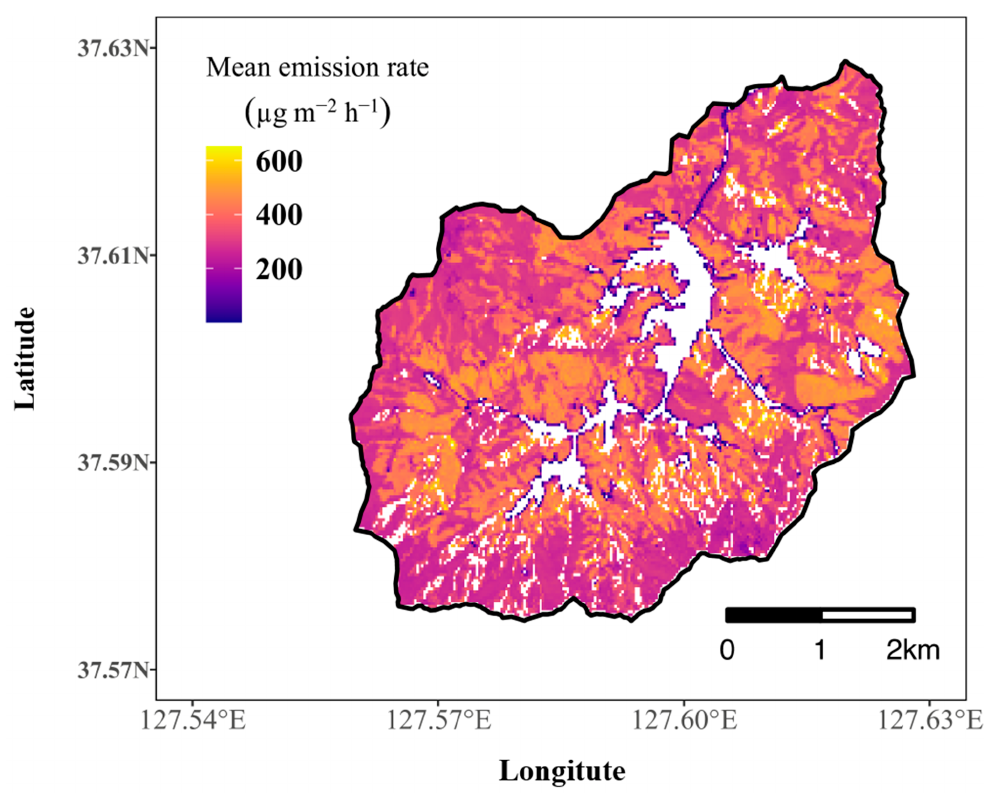
Figure 4. Spatial patterns of the terpene emission rate in Saneum-ri area in the year 2020. The average emission rate of the study area in the year 2020 was 347.2 µg m − 2 h − 1 ranging from 1.6 µg m − 2 h − 1 to 651.6 µg m − 2 h − 1 . The terpene emission in the model